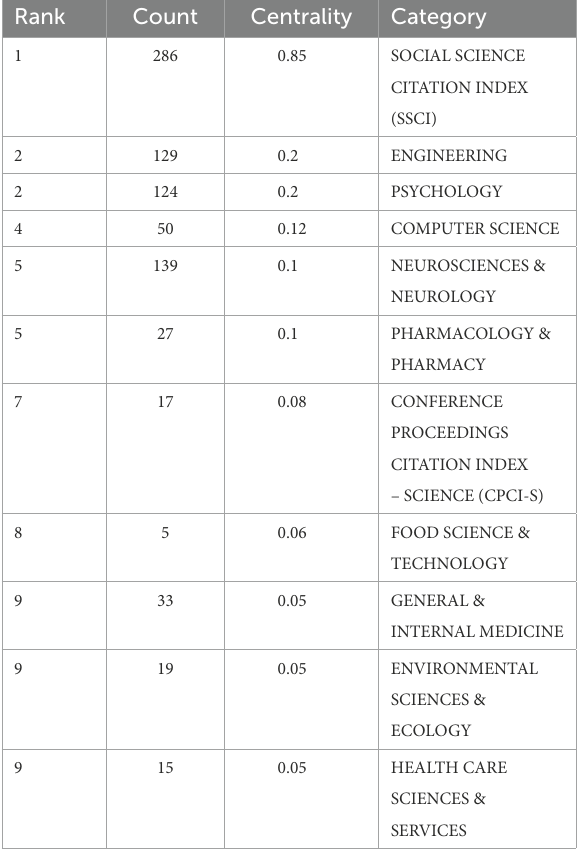
TABLE 1 Top 10 main category regarding ding effects of mental fatigue on athletic performance. Rank